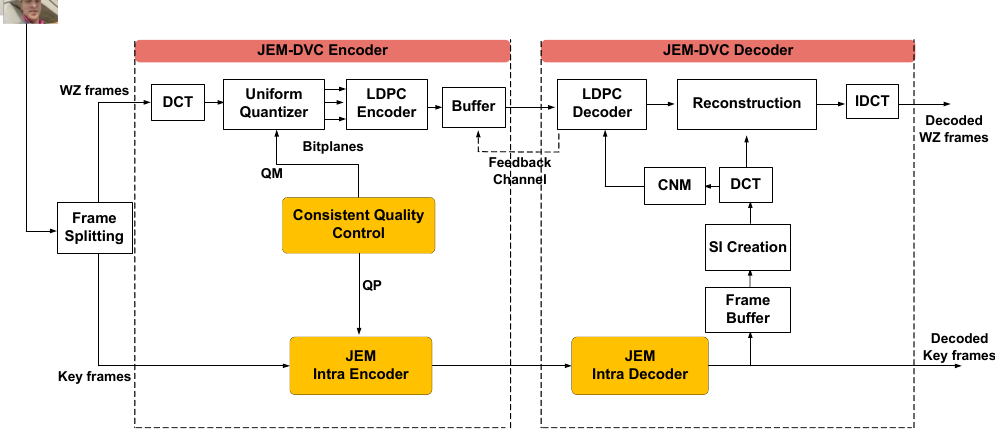
Figure 2. Proposed Joint exploration model based distributed video coding (JEM-DVC) architecture.